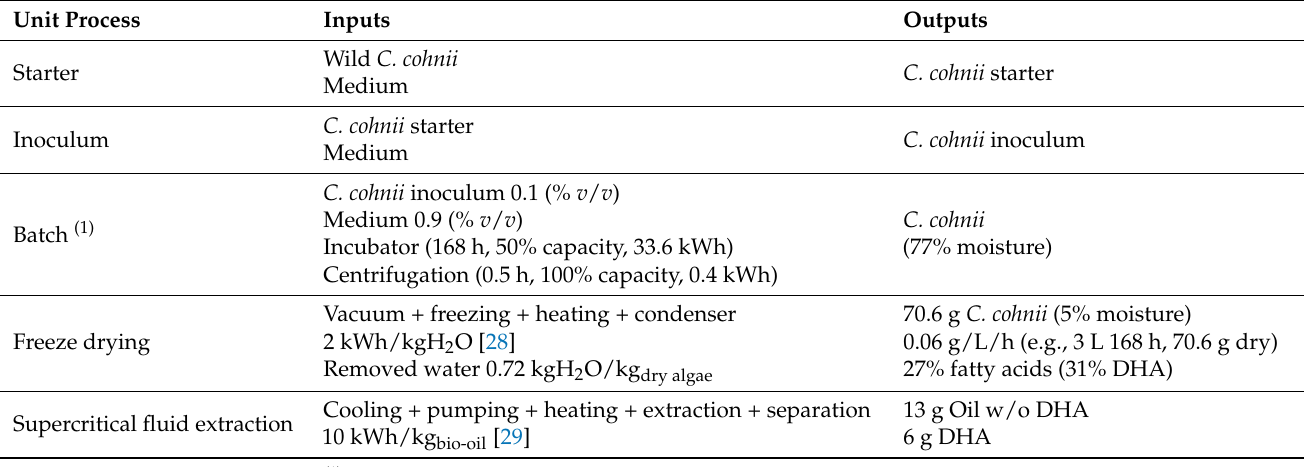
Table 1. Inventory for bench-scale.